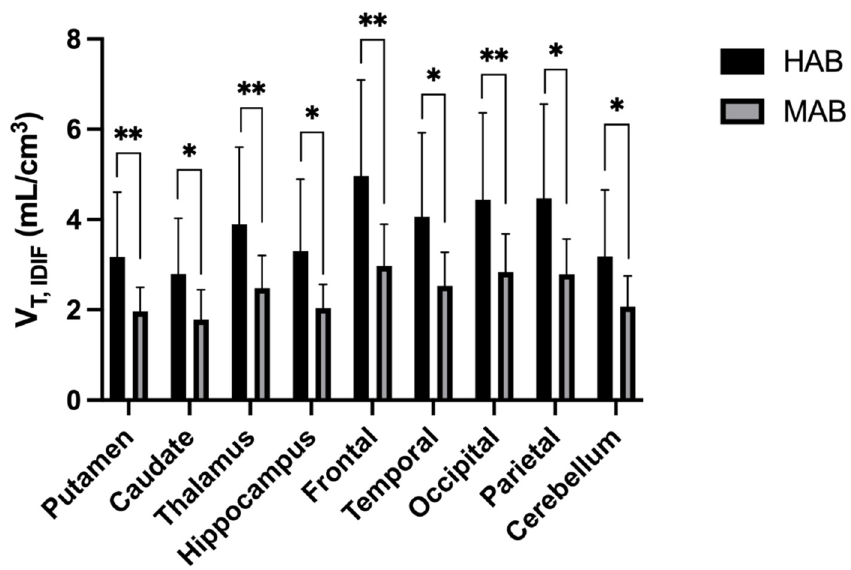
Figure 4. The box plot of the V T,IDIF . V T,IDIF is 37 ± 3% higher in HAB than in MAB. All nine regions were found with significant difference (*: p < 0.05, **: p < 0.01) between the HAB and MAB subjects. The overall increase pattern in the HAB is similar as the SUV pattern of increase.